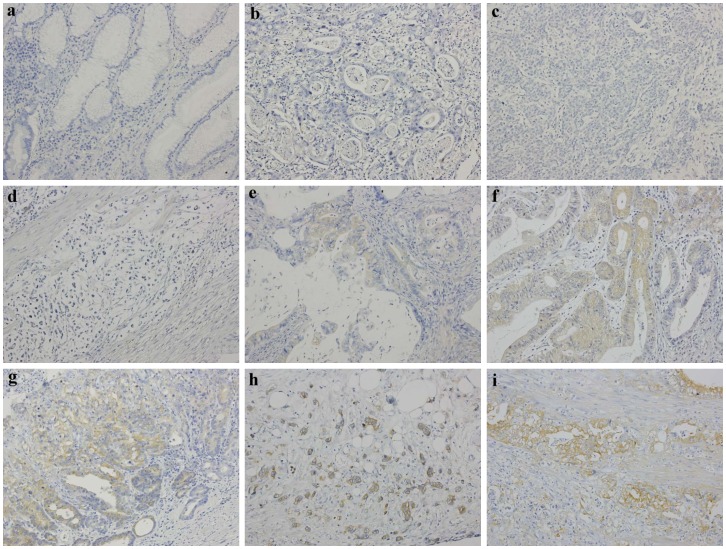
PKCα immunoreactivity in gastric carcinoma of various histologic type and differentiation.
a normal gastric glands showing negative immunostaining, b negative immunostaining in a moderately-differentiated adenocarcinoma of intestinal type, c negative immunostaining in a poorly-differentiated adenocarcinoma of intestinal type, d negative immunostaining of signet-ring cells in a diffuse type adenocarcinoma, e weakly positive immunostaining in a moderately-differentiated adenocarcinoma of intestinal type, f moderately positive immunostaining in a well-differentiated adenocarcinoma of intestinal type, g moderately positive immunostaining in a moderately to poorly-differentiated adenocarcinoma of intestinal type, h moderately positive immunostaining in a diffuse type adenocarcinoma, and i strongly positive immunostaining in a moderately-differentiated adenocarcinoma of intestinal type. Magnification: X200.